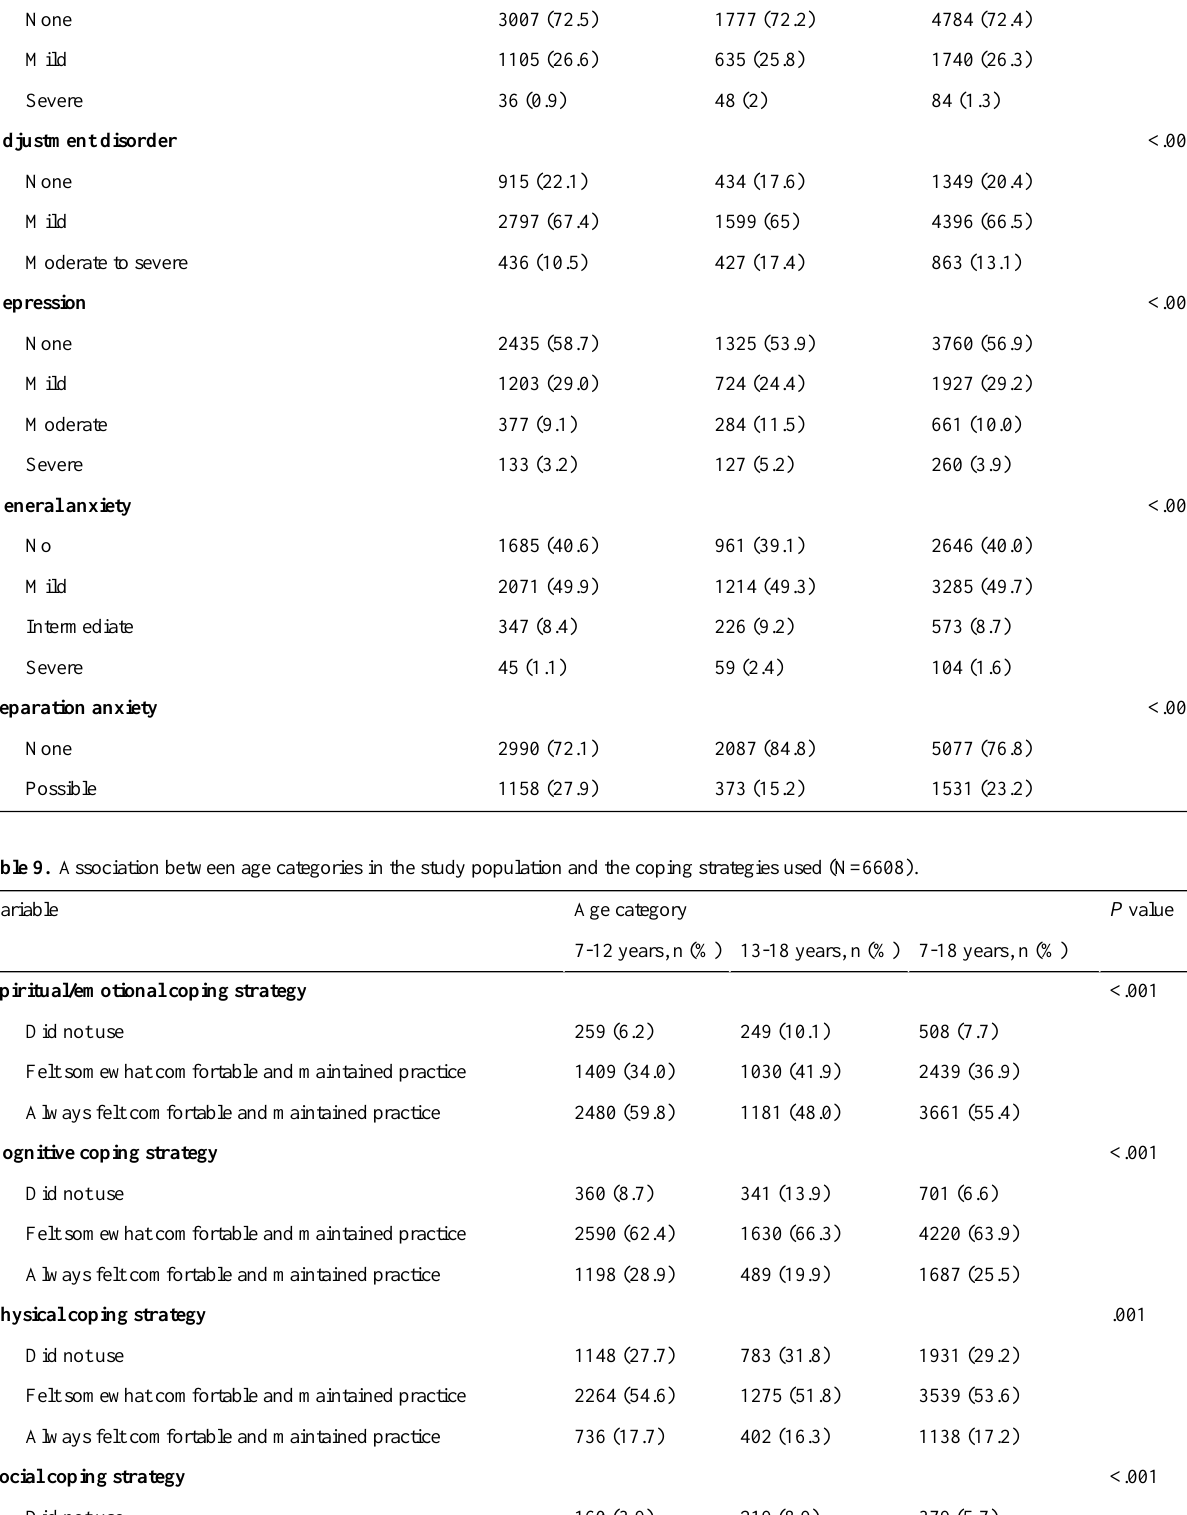
P valueAge categoryVariable